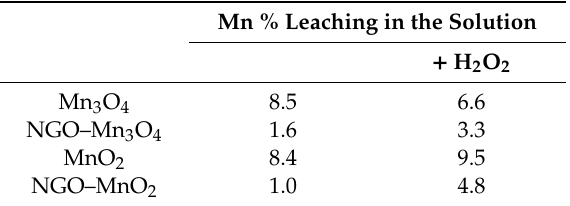
Table 3. Leaching of manganese in the solution after RB5